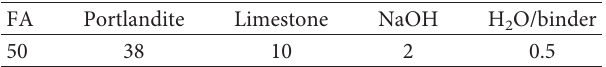
Table 2: Mix proportion of the system for pozzolanic reactivity tests